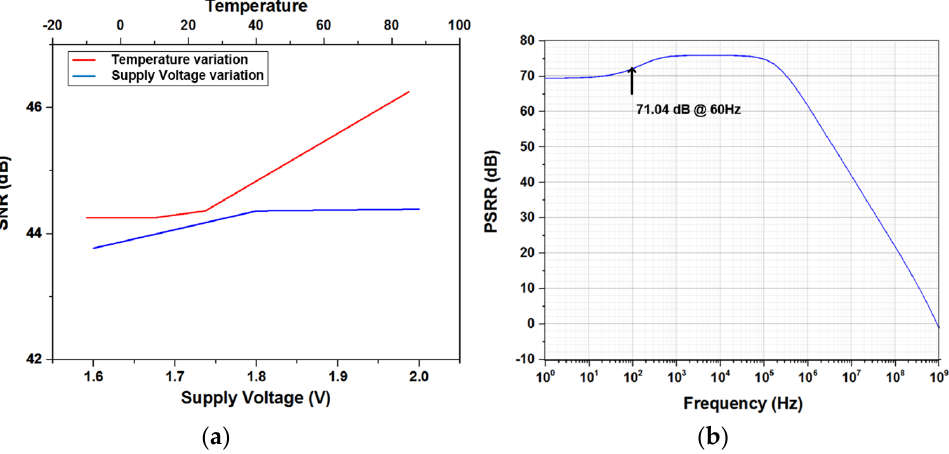
Figure 9. ( a ) Measured ROIC signal-to-noise ratios (SNRs) over temperature and supply-voltage variations, ( b ) ROIC power-supply rejection ratio ( PSRR) (simulated).